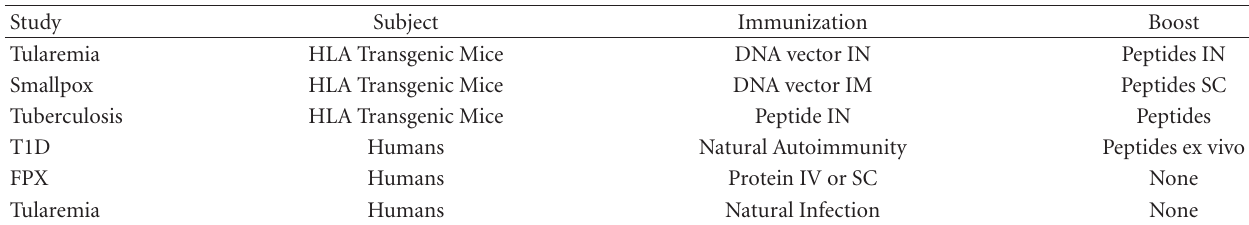
Table 1: Design of six di ff erent studies used to validate the iTEM predictions. In three cases, inbred HLA transgenic mice were used for measurements of vaccine immunogenicity. In the other three, human subjects were recruited for evaluations of immune responses to protein antigens.